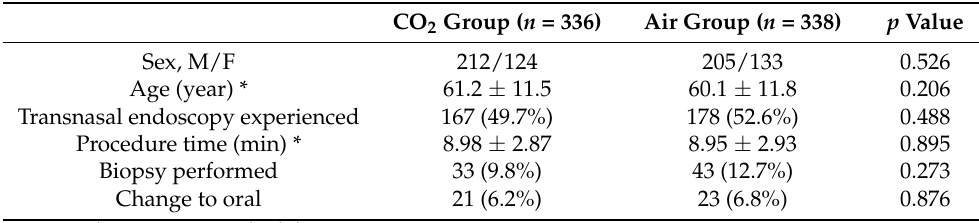
carbon dioxide (CO 2 ) and air